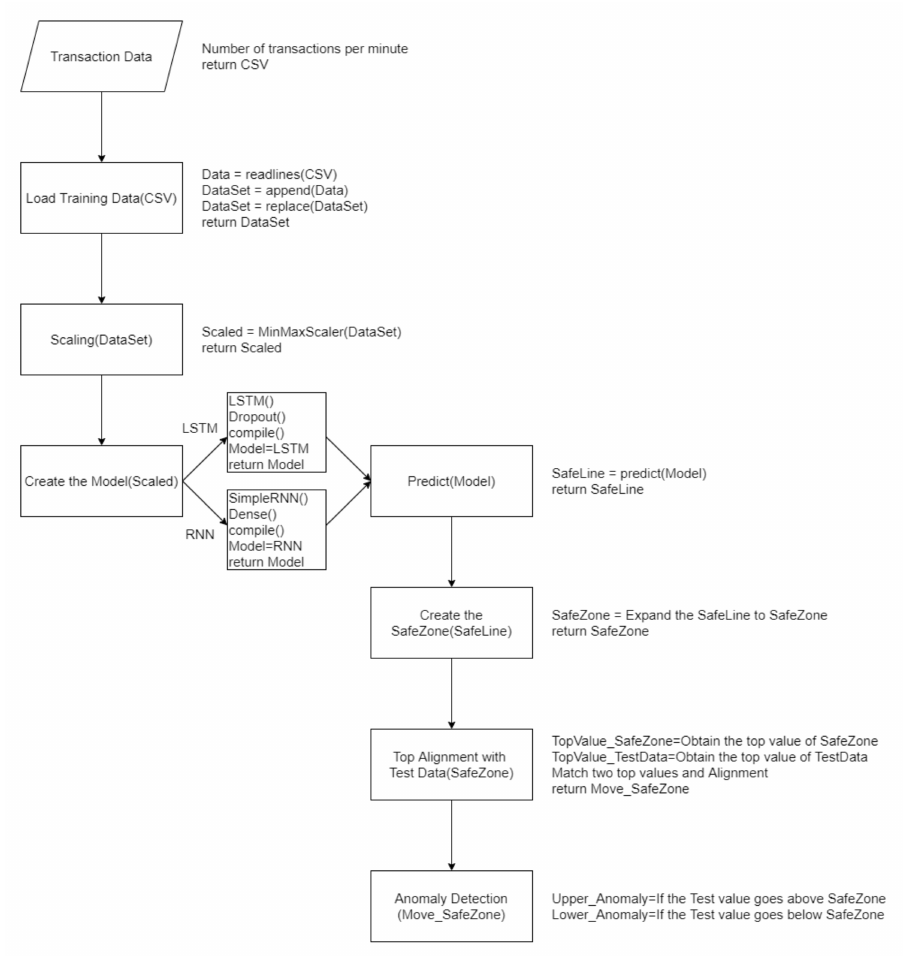
Figure 7. Flow chart of the experimental design using SafeZone